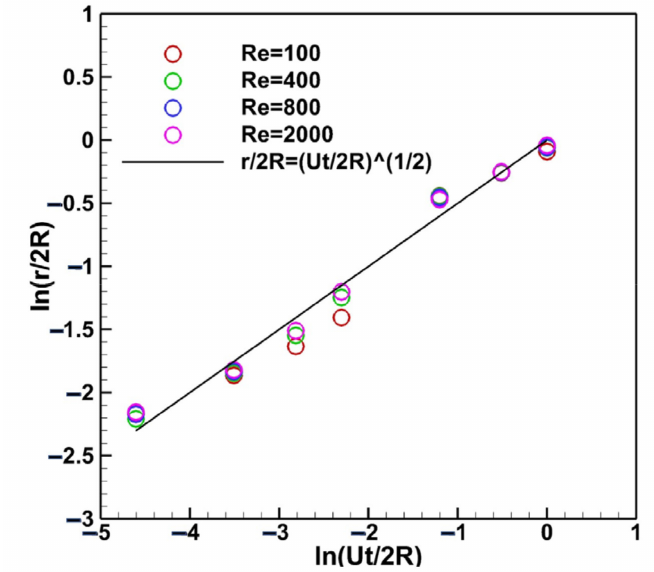
Figure 22. Comparison of the predicted spread radius with different Reynolds